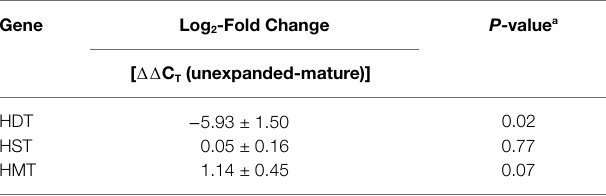
TABLE 5 | Real-time PCR analysis of expression of HDT, HST, and HMT in unexpanded and mature red clover leaves. Gene Log 2 -Fold